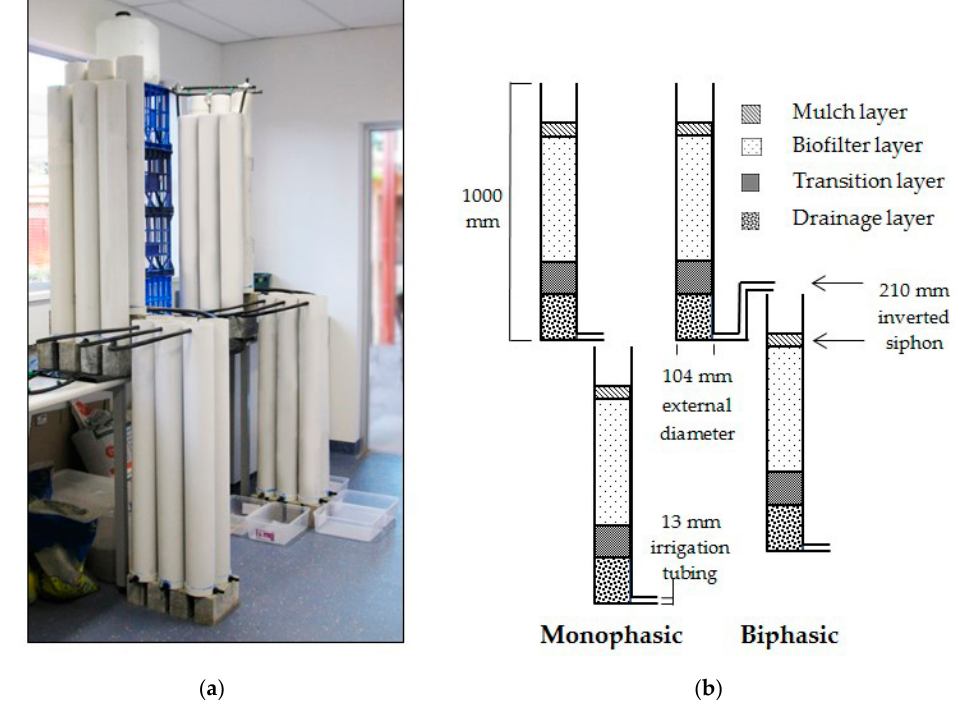
Figure 3. Laboratory columns: ( a ) view of general layout; ( b ) sectional schematic showing arrangement and layering.